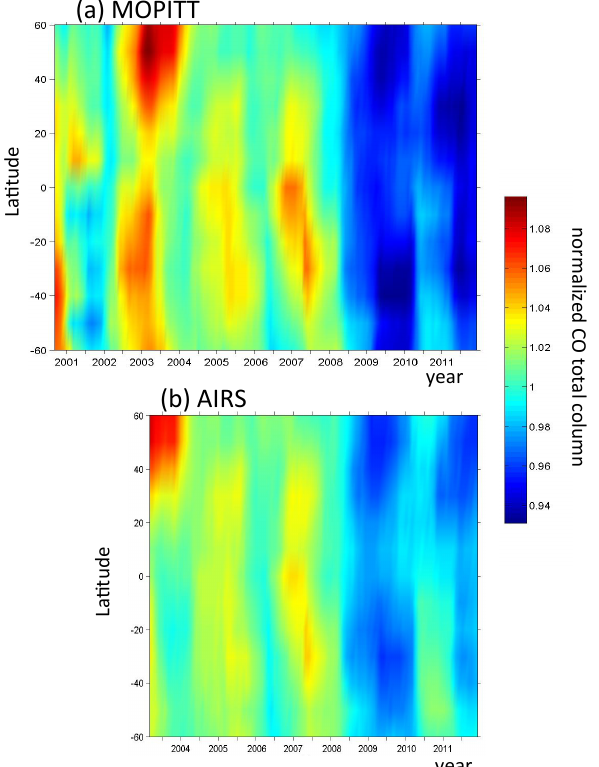
Fig. 9. Time series of normalized CO total column for zonal, 12- month running averages. Total CO columns are normalized to the average column in each 10 ◦ latitudinal band. (a) shows MOPITT data from Sep. 2000 to Nov. 2011. (b) shows AIRS data from April 2003 to November 2011. (First and last 6 months of 12-month run- ning averages are not considered, as described in the text.)